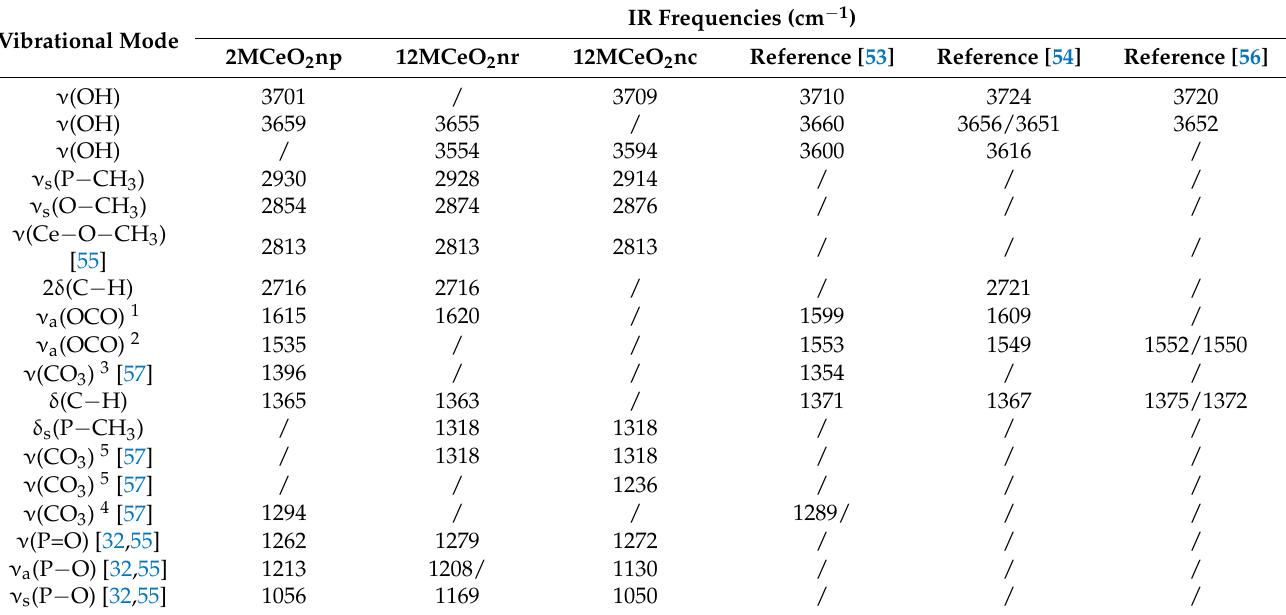
Table 7. Assignments of IR frequencies in surface